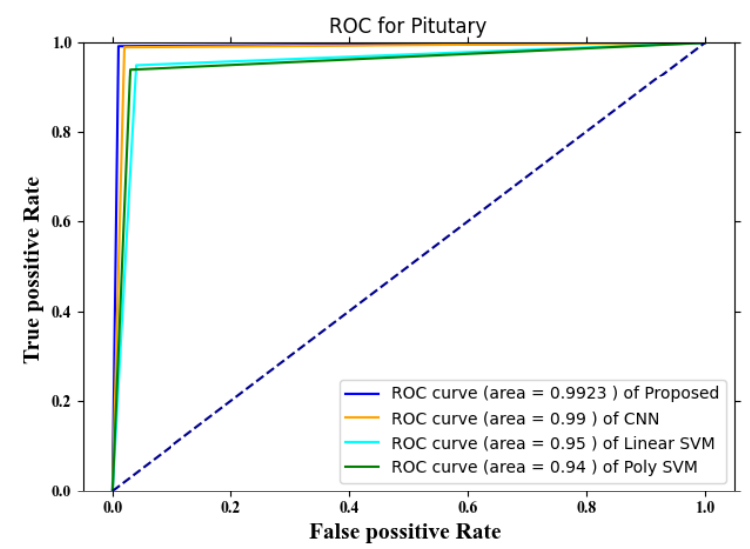
Figure 7. ROC for pituitary tumors.